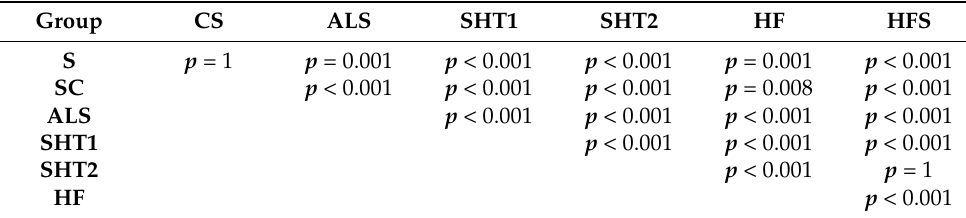
Table 3. Tamhane T2 test